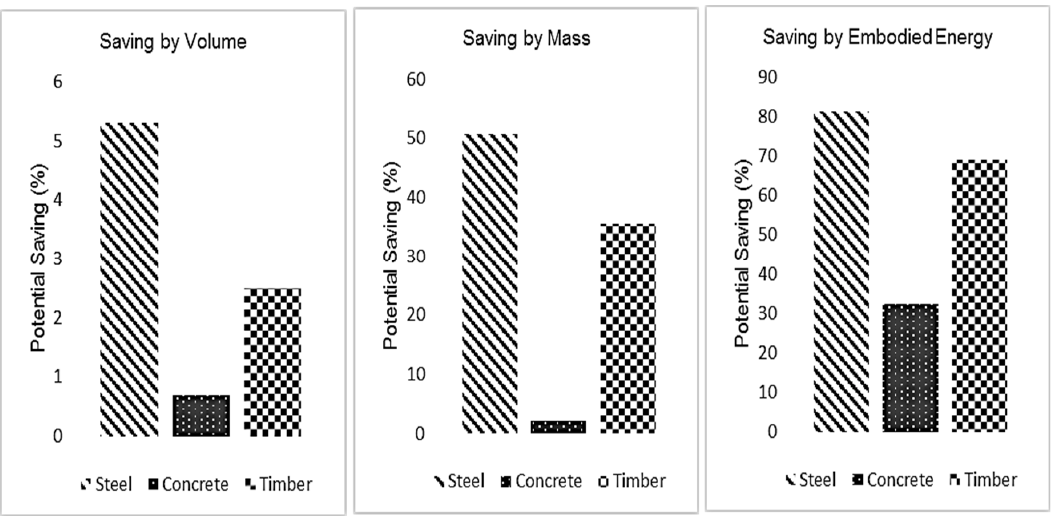
Figure 5. Total volume, mass and embodied energy of concrete and prefabricated steel and timber building scenarios, with percentage of potential savings achieved from the reuse of materials through Modular Construction [19].